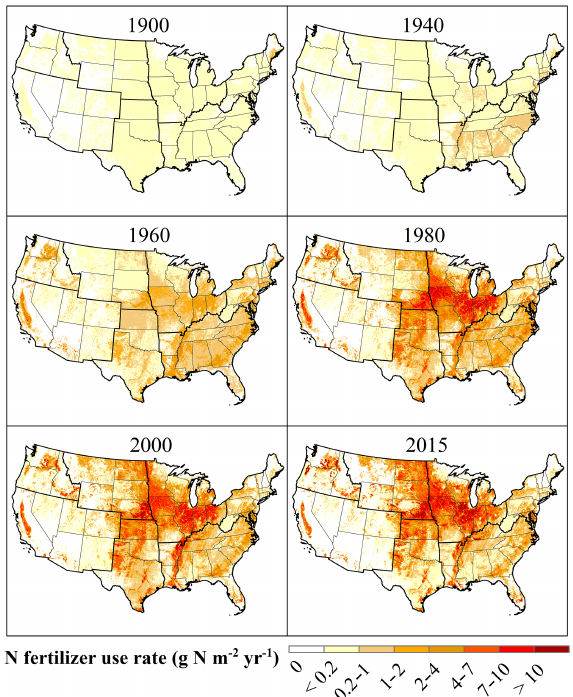
Figure 3. Spatial distribution of N fertilizer uses in the contiguous US from 1900 to 2015. Values represent agricultural average N use rate over all crops in each 5km by 5km grid cell.